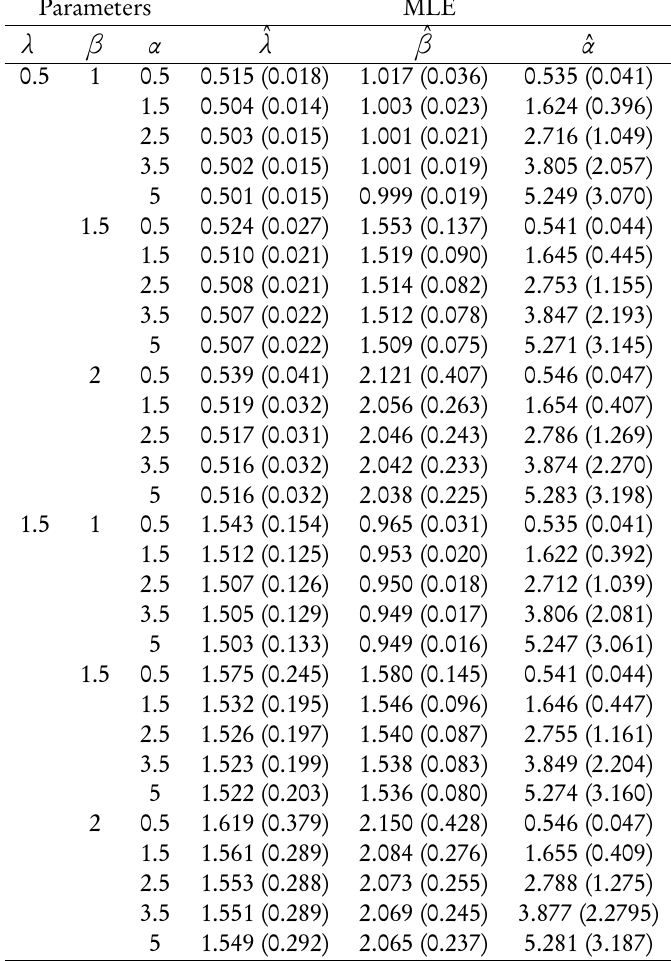
Average value of the estimates of the parameters and the corresponding MSEs (in parentheses) for n = 100